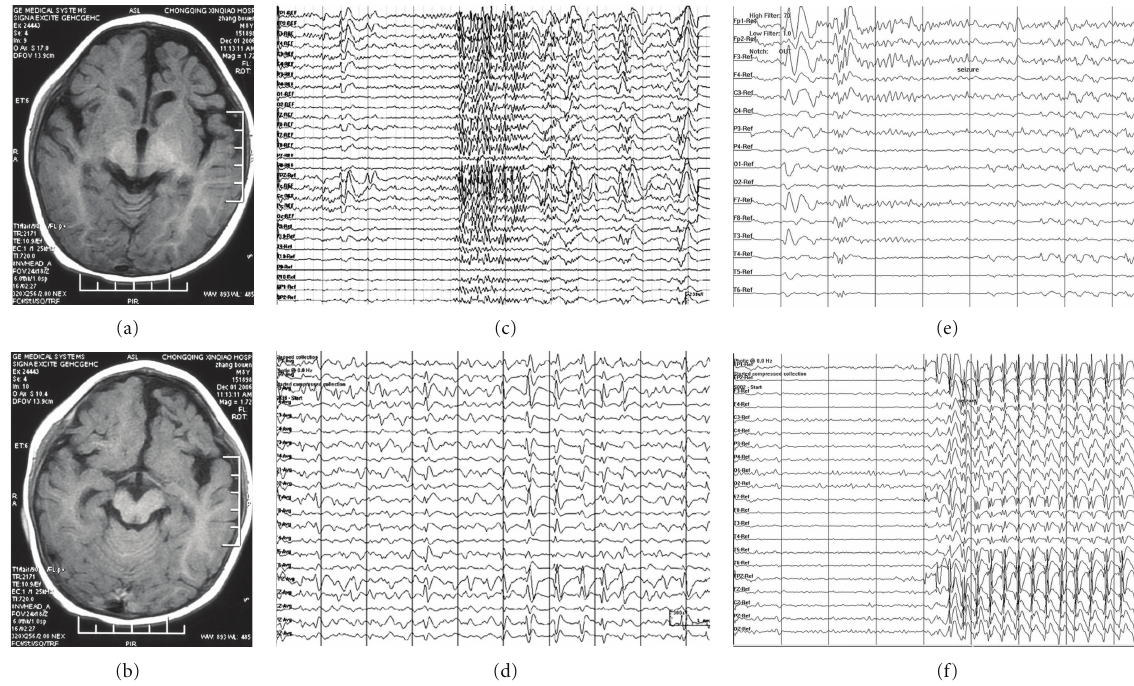
Figure 2: Clinical data of a patient with left frontal lobe atrophy. (a) and (b): MRI scan showing atrophy of left frontal lobe. (c) EEG showing PFA. (d) EEG showing SSW. (e) EEG showing epileptiform discharges during a tonic seizure. (f) EEG showing epileptiform discharges during an atypical absence. Data were from patient no. 13 in Tables 1 and